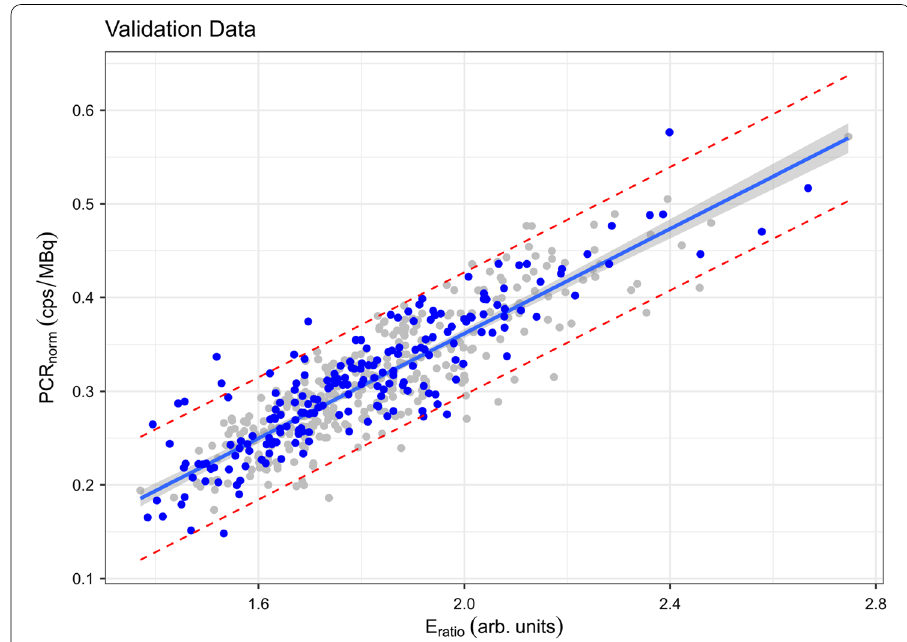
Fig. 2 Final linear regression as shown in Fig. 1, with training dataset values in grey and superimposed validation dataset values in blue. Image generated in